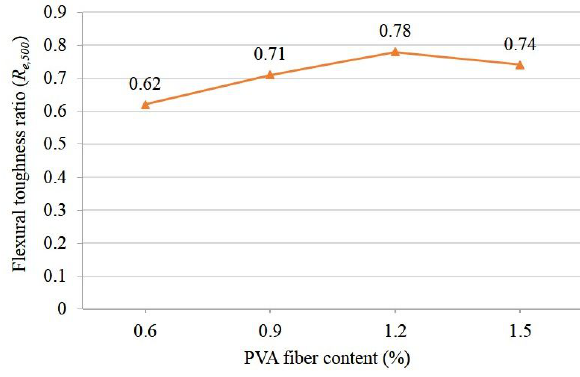
Figure 10: Initial flexural toughness ratio ( R e , p ) of NS composites